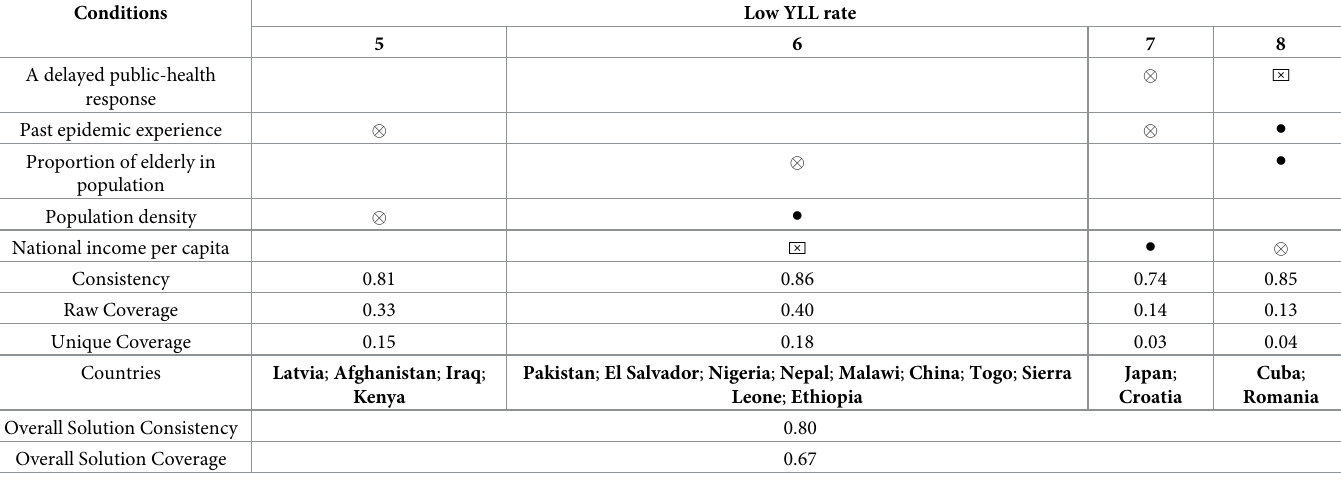
Table 4. Configurations for low YLL